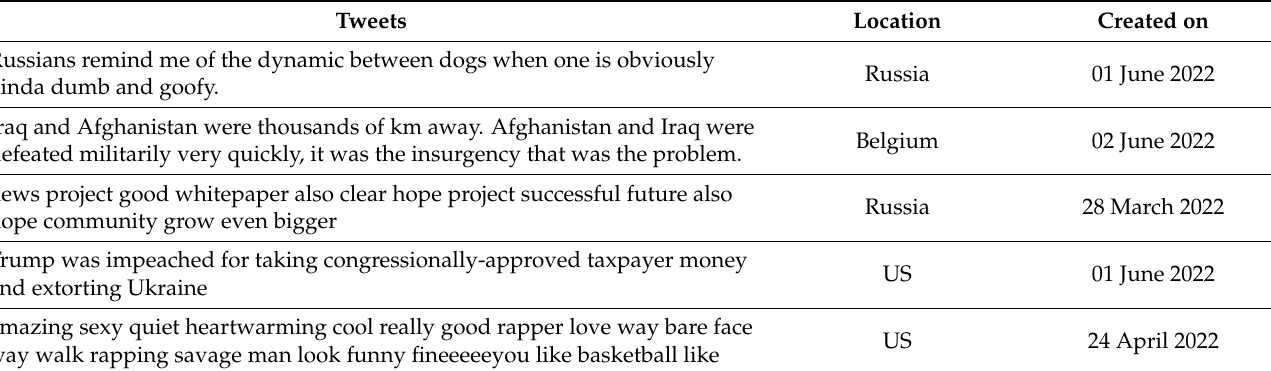
Table 9. Most frequent words using NMF and LDA.